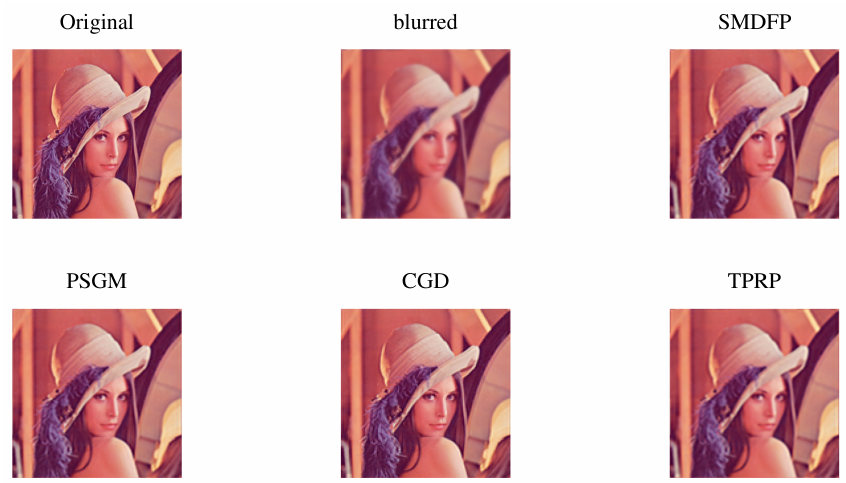
Figure 8. Comparison of the original image, blurred image, SMDFP image, CGD image, PSGM image, and TPRP image for the number of iterations, CPU time, MSE, and SNR.